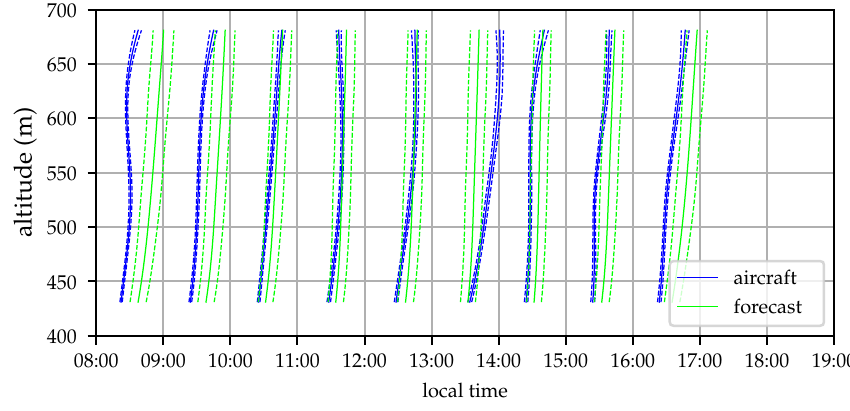
Figure 22. Evolution of the forecast and aircraft-estimated cost of traveling southwest at a groundspeed of 15 m s − 1 (2018-12-06). Cost profiles are scaled such that one hour represents 4 m s − 1 of specific power required to fly this mission. Systematic, slowly varying differences between the forecast and estimated cost profiles are seen.